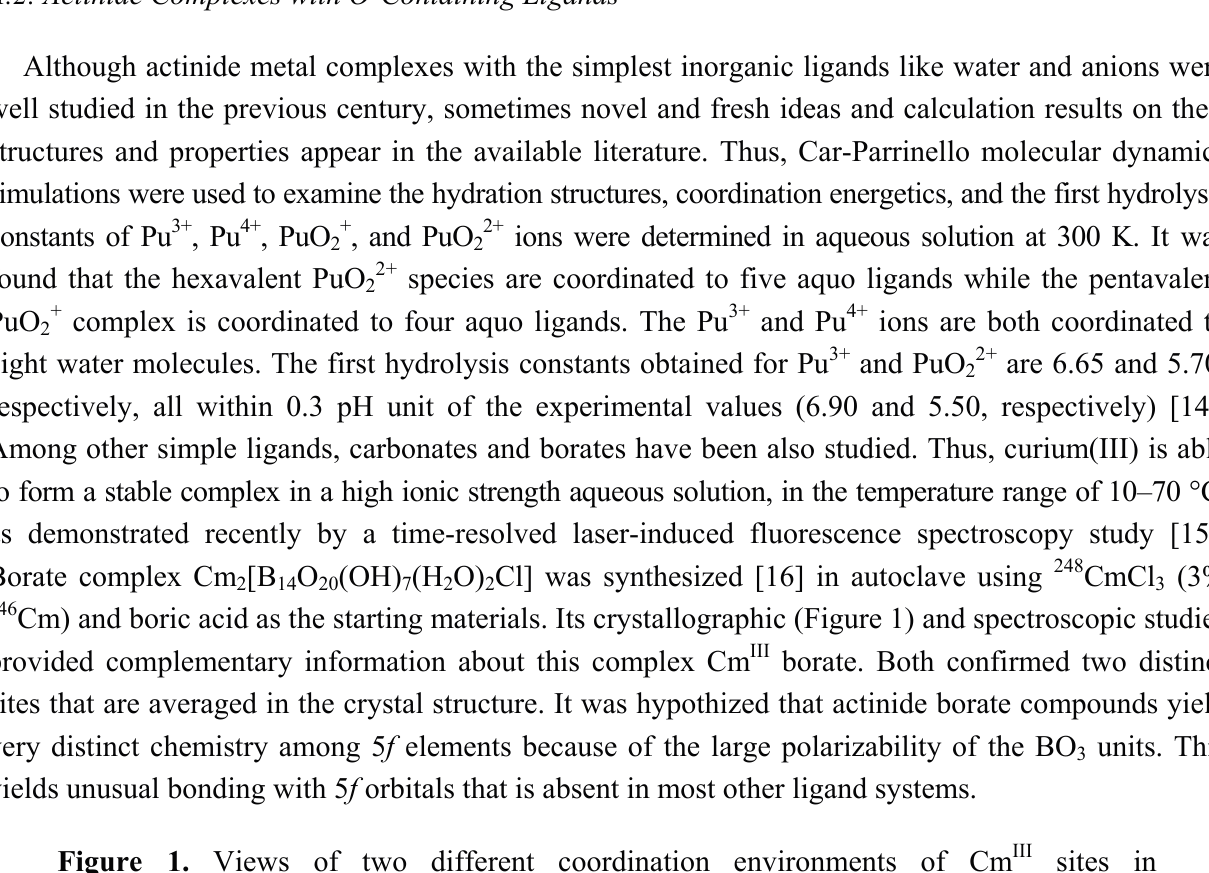
Figure 1. Views of two different coordination environments of Cm III sites in [B O (OH) (H O) Cl] with resolved disorder. ( a ) Nine-coordinated Cm(III) Cm 2 14 20 7 2 2 complex; ( b ) Ten-coordinated Cm(III) complex.